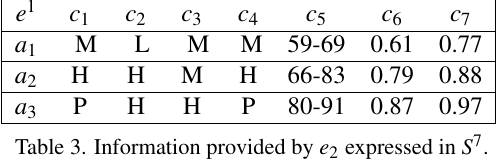
Fig. 4. Linguistic comparison